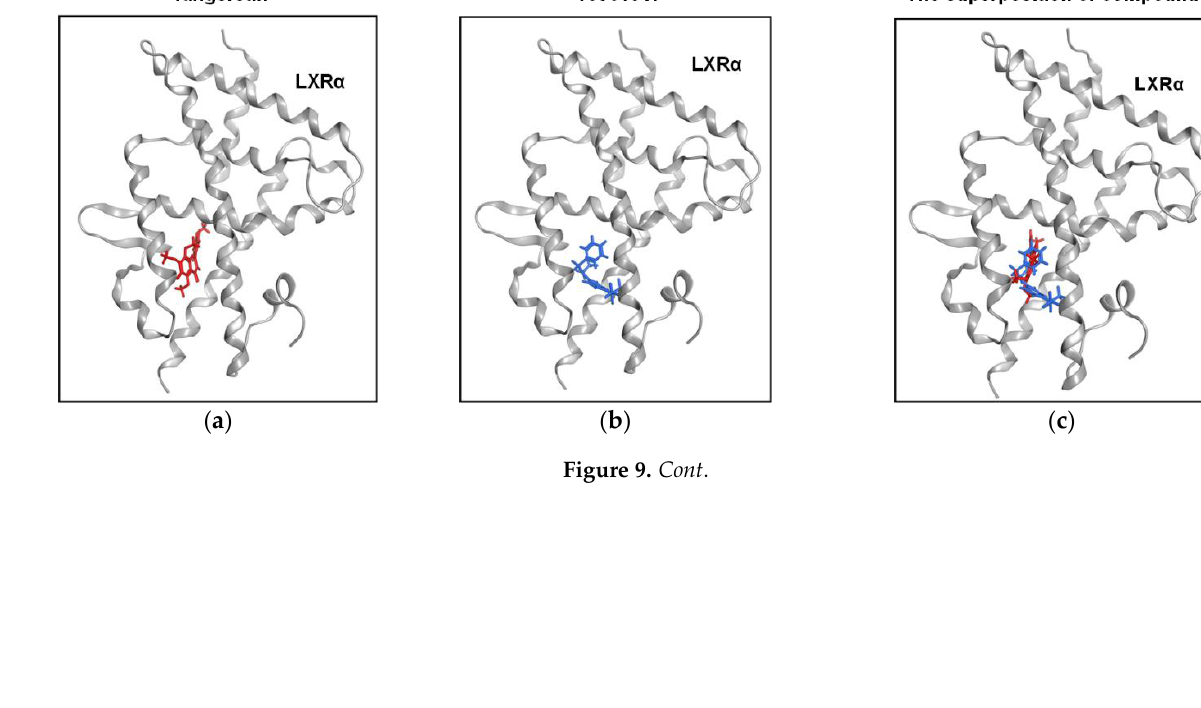
Figure 8. Effects of tangeretin on ANGPTL3 transcription upon T0901317-induced LXRα activation in HepG2 cells. ( a ) HepG2 cells were cotransfected with an ANGPTL3 promoter–reporter plasmid (ANGPTL3 p( − 250/+20)) and a Renilla control plasmid for 24 h. These plasmid-transfected cells were pretreated with vehicle or tangeretin (40 µ M) for 1 h followed by treatment with T0901317 (1 µ M) for an additional 24 h. The luciferase activities were measured and normalized to their respective Renilla luciferase activities. The data represent the mean ± SD from three independent experiments. ( b ) HepG2 cells were pretreated with vehicle or tangeretin (40 µ M) for 1 h followed by treatment with T0901317 (1 µ M) for an additional 24 h. The mRNA levels of ANGPTL3 were measured by RT-Q-PCR analysis. ** p < 0.01 indicates a significant difference compared to vehicle-treated cells. ## p < 0.01 indicates significant differences compared to the T0901317 alone-treated cells.